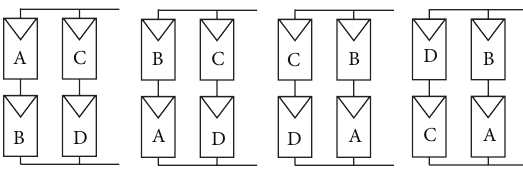
Figure 2: Equivalent connections in a 2 × 2